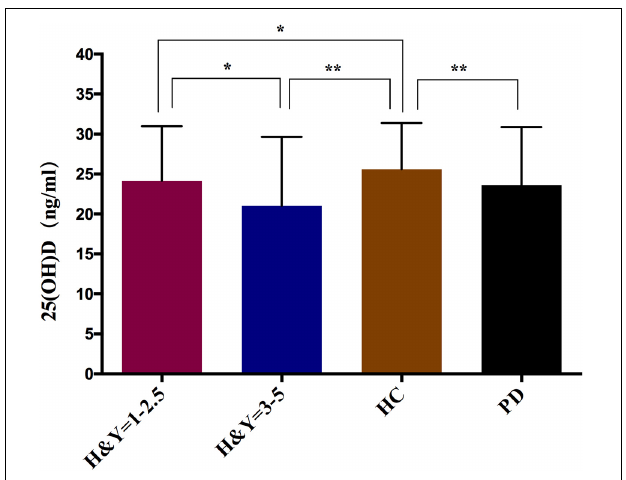
FIGURE 1 | Comparison of serum 25(OH)D levels in PD patients and healthy controls. * p < 0.05, ** p < 0.01; P -values were calculated using Student‘s t